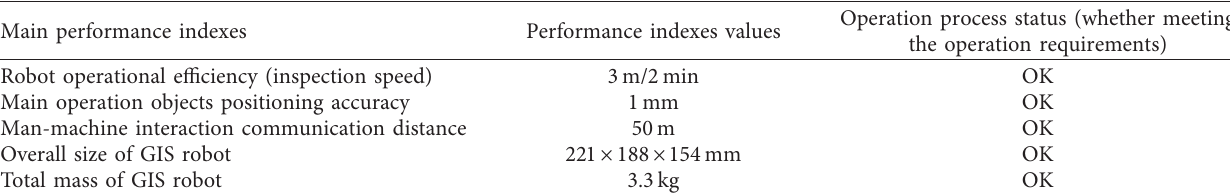
Figure 14: GIS inspection robot field operation experiment. (a) GIS robot field operation state 1, (b) GIS robot field operation state 2, (c) GIS robot field operation state 3, and (d) GIS robot field operation state Table 2: The main performance indexes of GIS inspection robot.